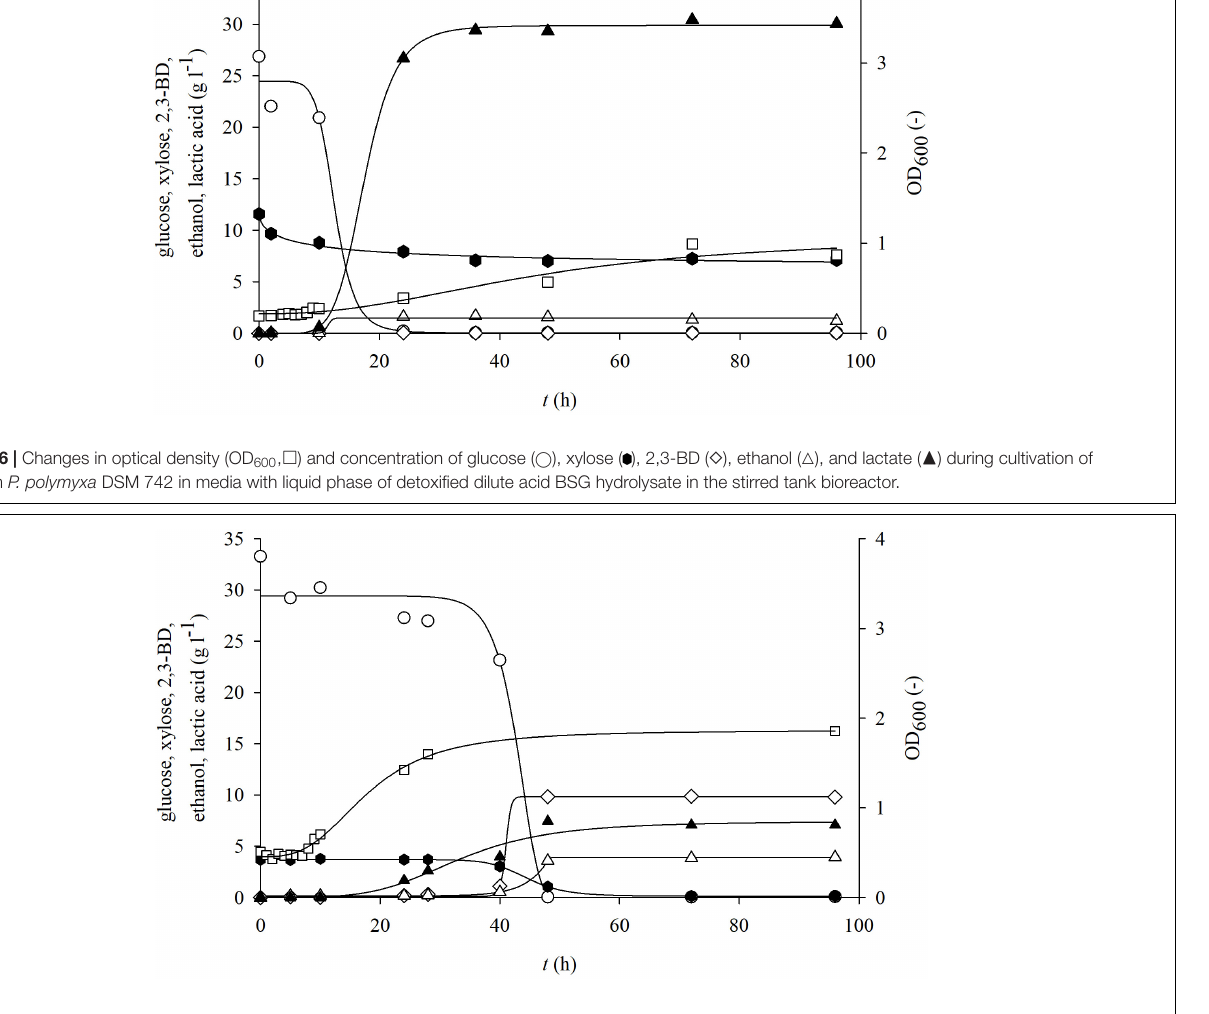
FIGURE 7 | Changes in optical density (OD 600 , (cid:3) ) and concentration of glucose ( (cid:13) ), xylose ( ), 2,3-BD ( (cid:5) ), ethanol ( (cid:52) ), and lactate ( (cid:78) ) during cultivation of bacterium P. polymyxa DSM 742 in media with enzymatically hydrolyzed solid phase of dilute acid BSG hydrolysate in the stirred-tank